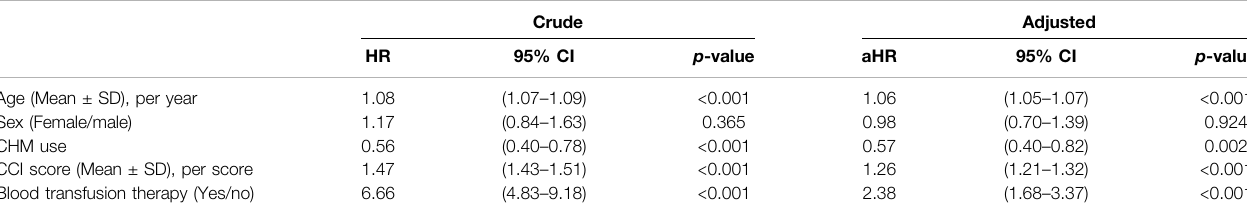
TABLE 3 | Risk of diabetes-related mortality in patients with hereditary hemolytic anemias (HHAs) in